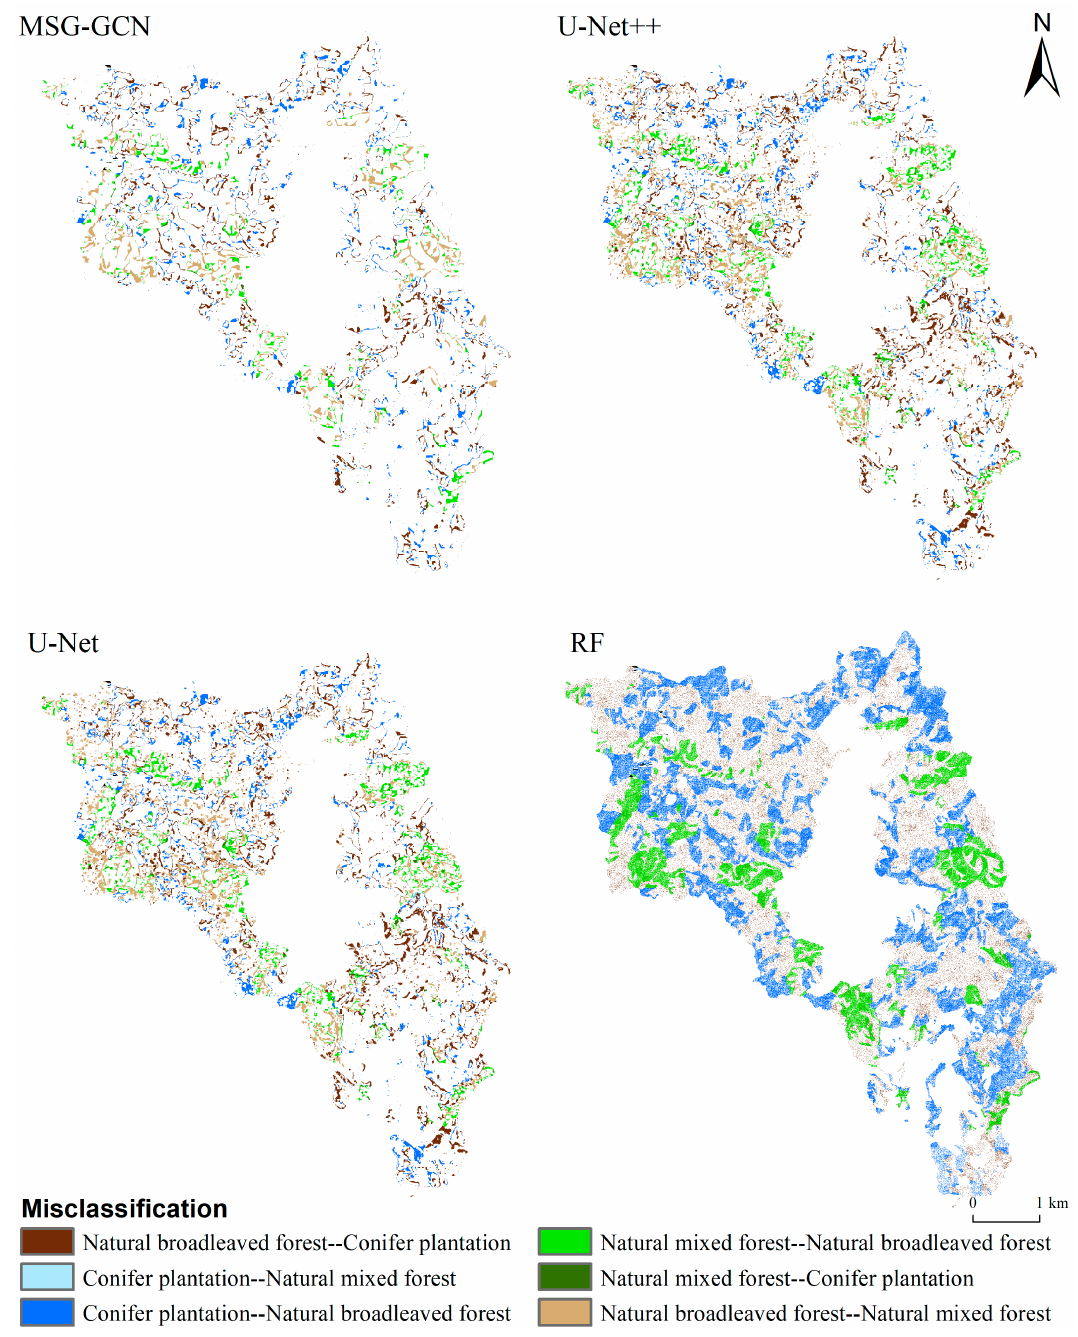
Figure 10. The forest types misclassified by the various models.